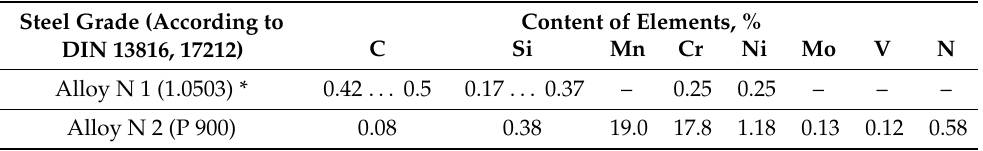
Table 1. Chemical composition of the investigated steels.